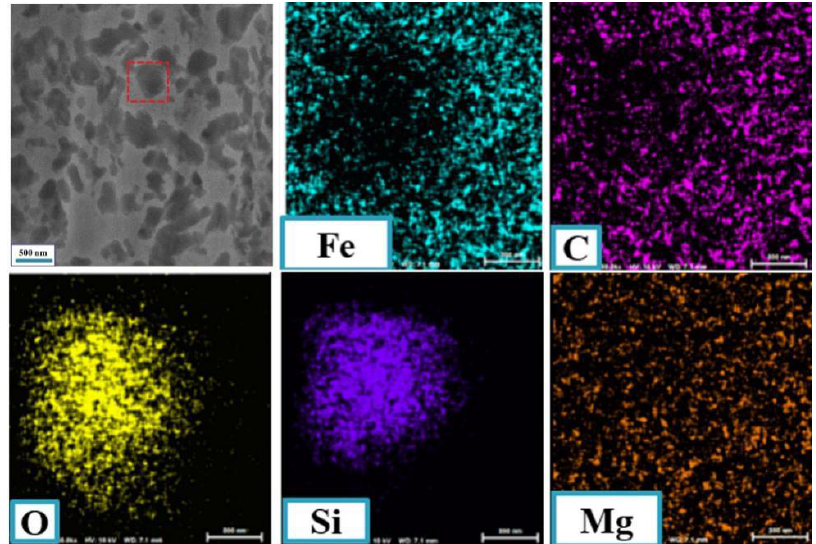
Figure 6. Elemental mapping of the worn surface of the steel ball under the lubrication of LP + 0.5 wt Figure % NSPs.